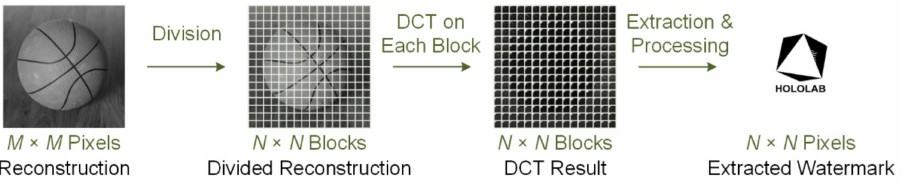
Figure 5. The extraction of the watermark from the optically reconstructed image.